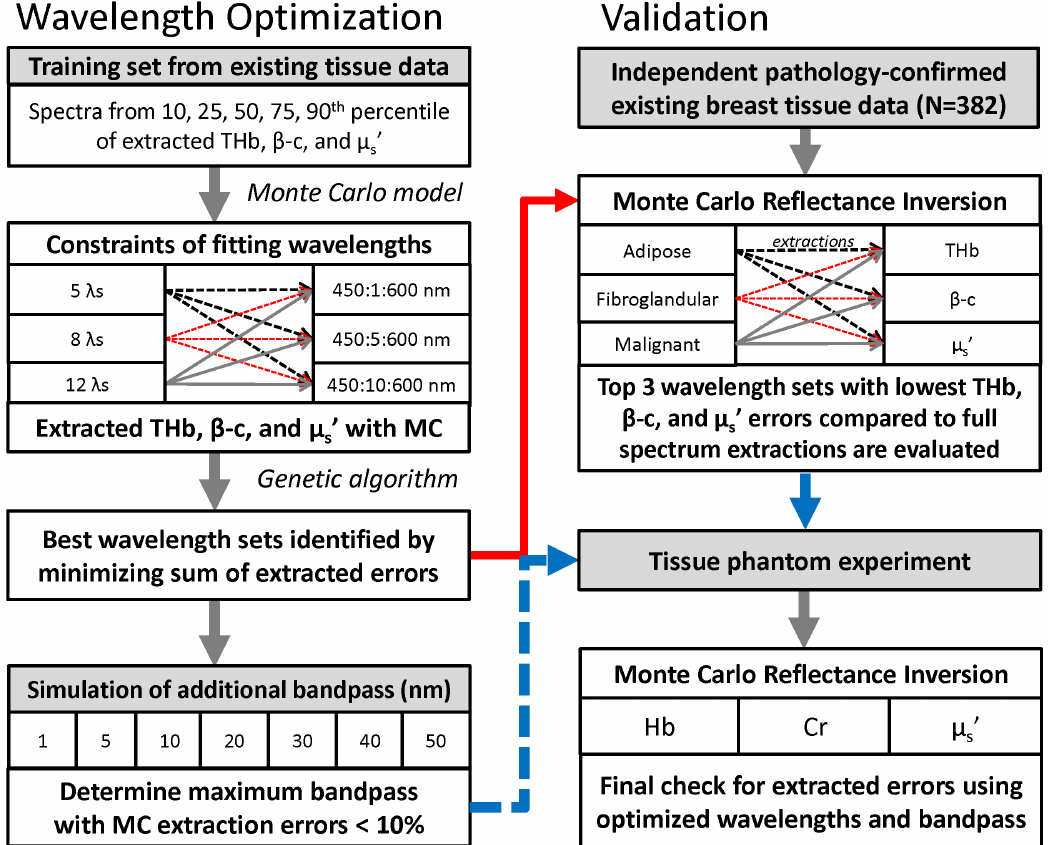
Figure 1. General flow chart of wavelength selection method. General flow chart illustrating the process for selecting and testing optimal wavelength sets and spectral bandpass in clinical data obtained from breast tumor specimens and in tissue phantoms.